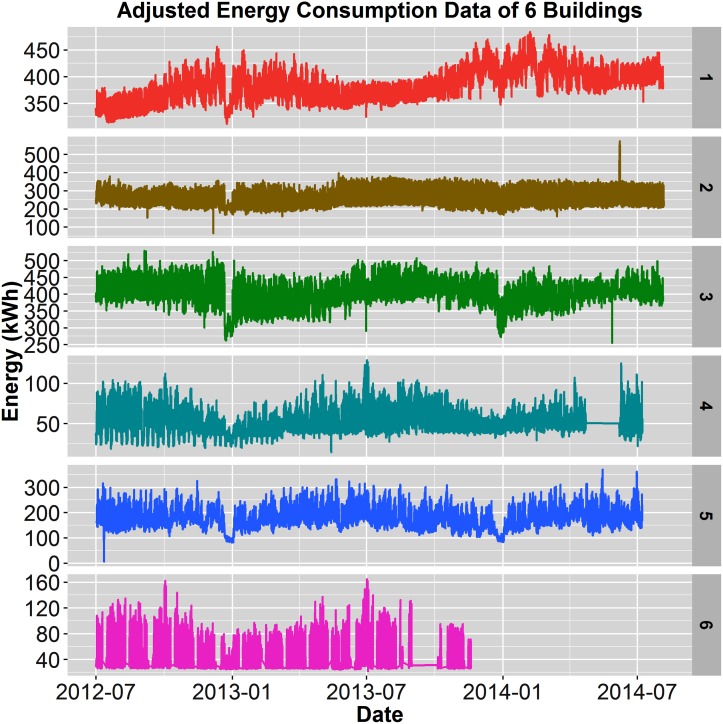
Cleaned electricity data.Cleaned electricity consumption of full datasets for all 6 buildings.